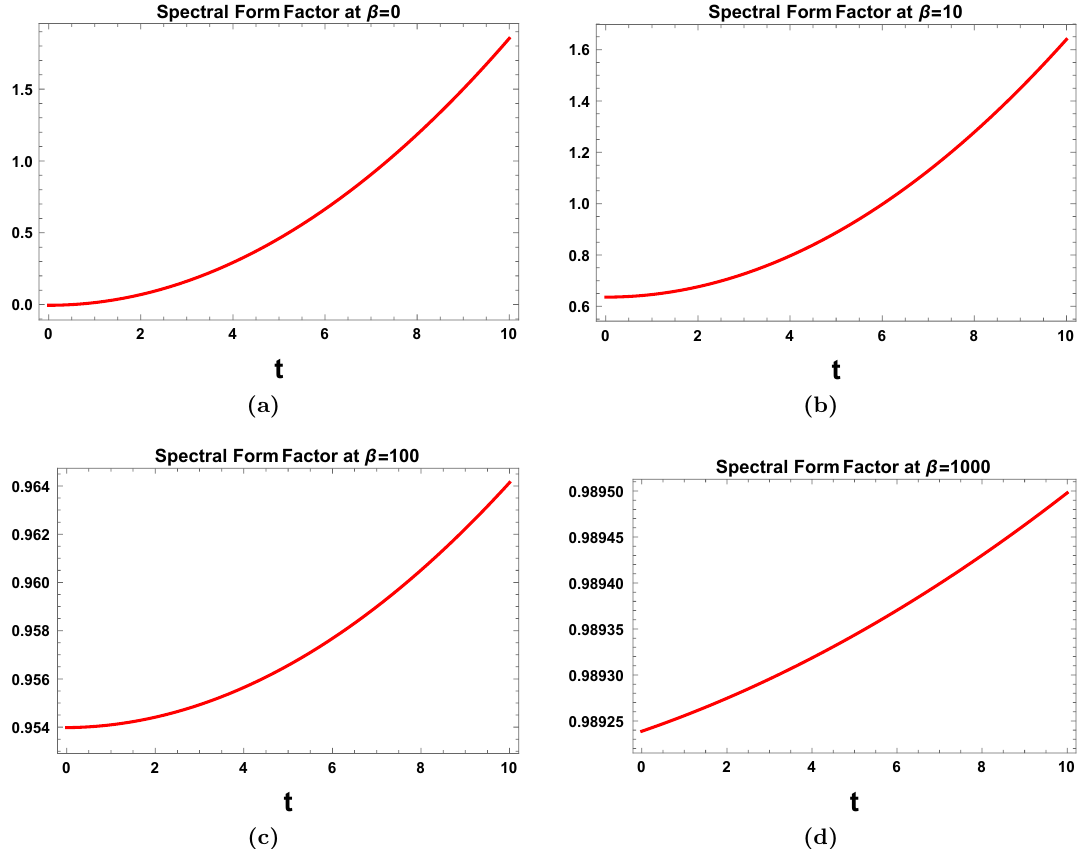
Figure 2 . Early time behavior for cubic